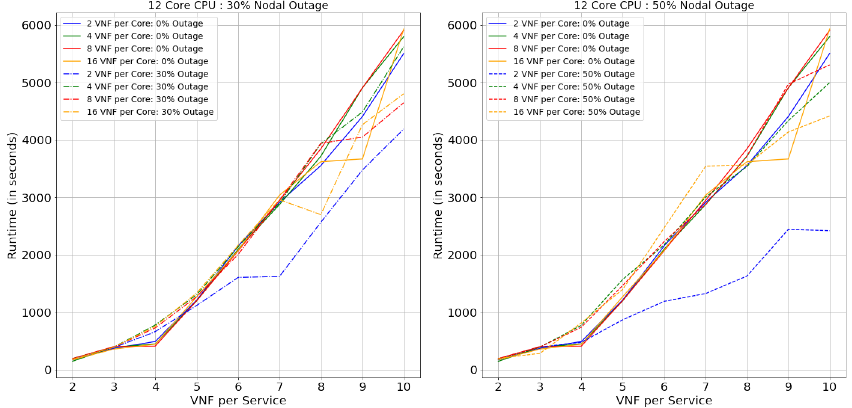
Figure 28. Runtime: BtEurope topology with nodal outage—12 core